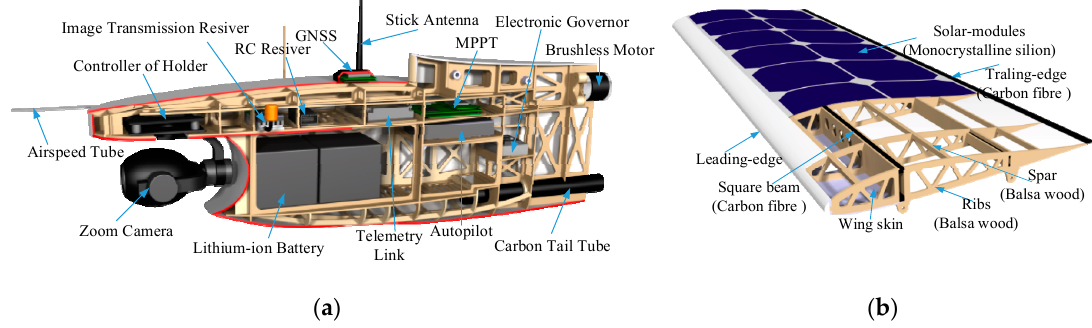
Figure 9. ( a )The fuselage structure and arrangement of instruments, ( b ) wing structure.